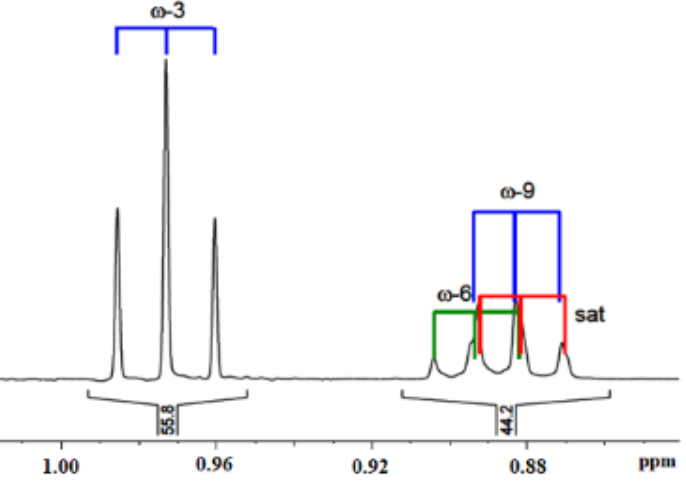
Figure 7. Separation of ω -3 from ω -6, ω -9 and saturated fatty acids on the basis of 1 H-NMR chemical shifts of –CH 3 groups. Free download from: http://www.ilps.org/index.php/Standardized_Methods. html.